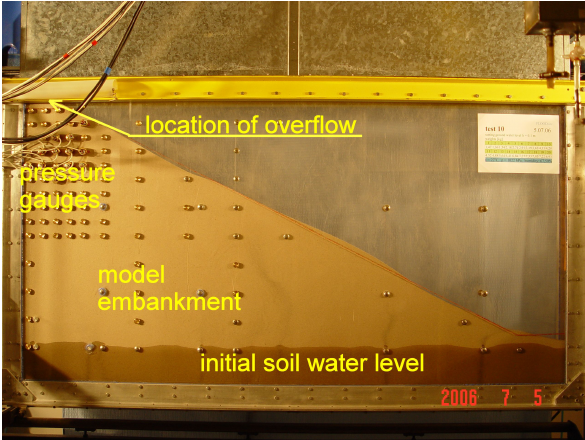
Figure 1: Components of the test rig.